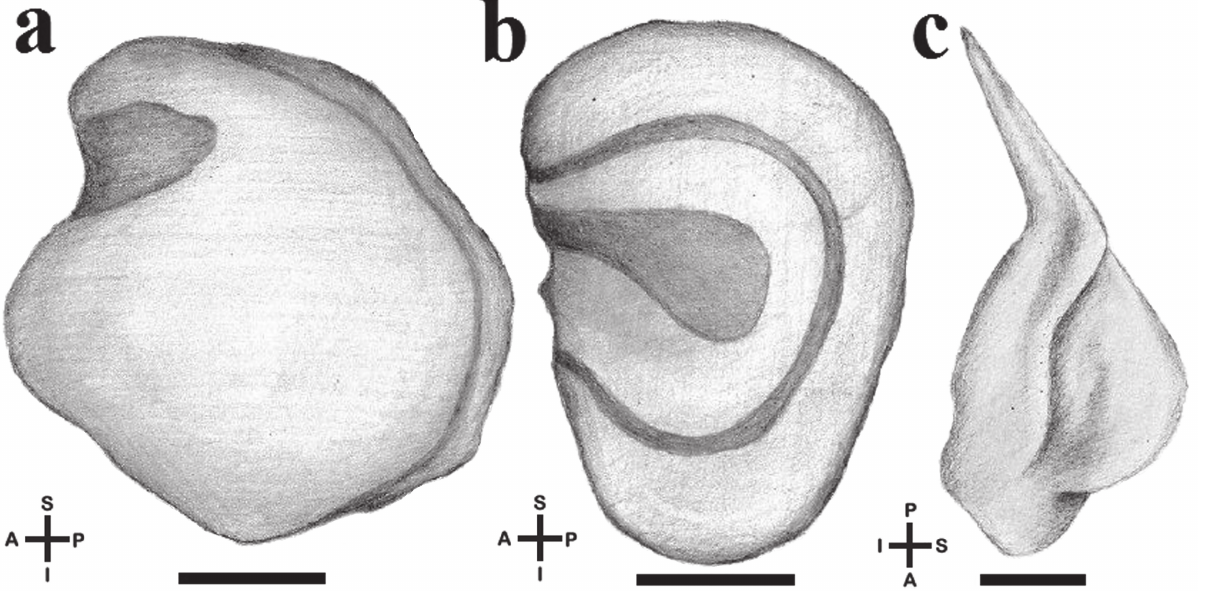
Fig. 7. Right serie of otoliths of Paraloricaria vetula (a) Lapillus, Scale bar = 500 µm; (b) Asteriscus, Scale bar = 500 µm; (c) Sagitta, Scale bar = 500 µm.